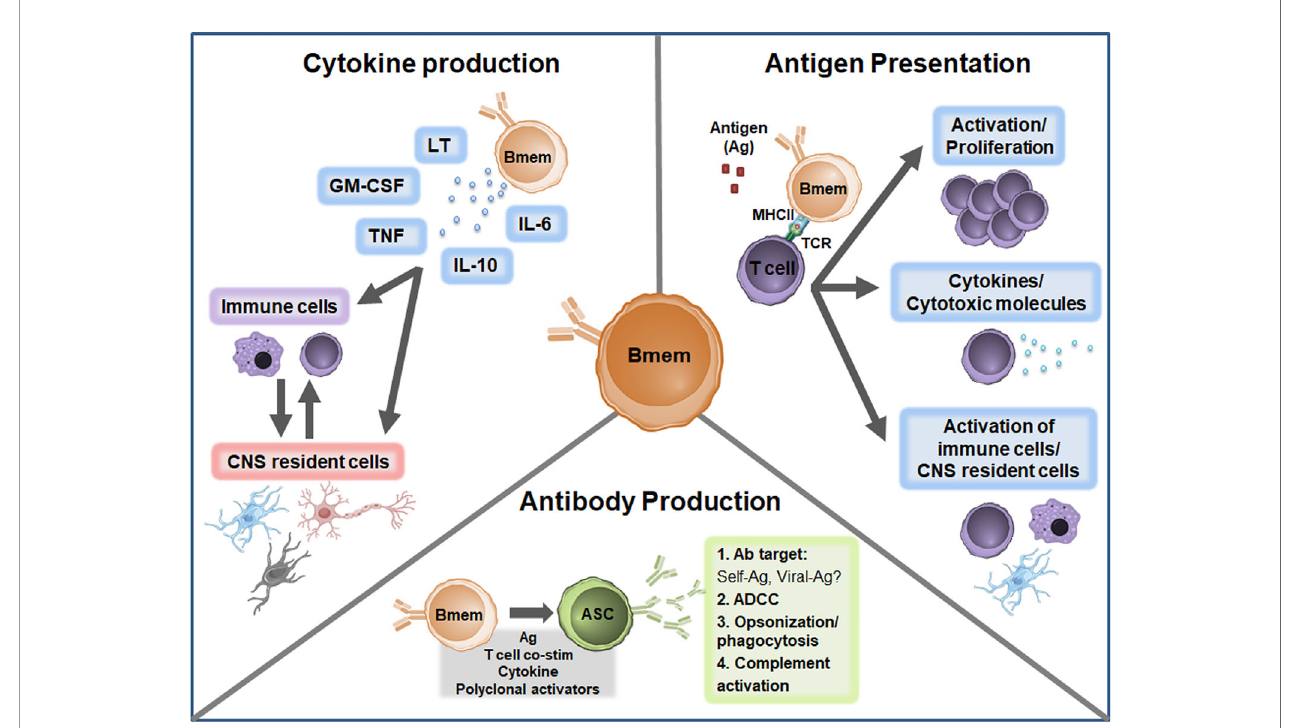
FIGURE 3 | Proposed Bmem functions in MS. Canonical Bmem functions include cytokine production, antigen presentation, and antibody production. Bmem may produce a variety of pro-in fl ammatory and anti-in fl ammatory cytokines in MS, including lymphotoxin (LT), GM-CSF, TNF, IL-10, and IL-6. The production of these cytokines may 1) modulate the in fl ammatory function of immune cells, including monocytes and T cells in the periphery or CNS or 2) may alter the function and survival of CNS resident cells, including neurons, astrocytes, microglia, and oligodendrocytes. Bmem-derived cytokines may also modulate the interactions between CNS-localized immune cells and CNS resident cells. Bmem are potent antigen presenting cells (APCs) and upon uptake and presentation of antigen (Ag) may interact with other immune cells, including T cells, to enhance cell proliferation and effector functions. For example, following T cell-Bmem interaction, activated T cells may engage in cytokine production or cytotoxic molecule secretion. Bmem antigen presentation to T cells may also modify T cell engagement with other immune cells in the periphery or CNS and interaction with CNS resident cells. Bmem can differentiate into ASC following stimulation, including re-exposure to antigen, T cell co-stimulation (co-stim), cytokine stimulation, or T cell-independent polyclonal stimulation. Upon differentiation, Bmem-derived ASC may be involved in sustaining antibody responses in the CNS compartment. Bmem-derived ASC may also contribute to several antibody-dependent functions implicated in MS, including targeting self or viral antigens, antibody-dependent cellular cytotoxicity (ADCC), opsonization/phagocytosis, and complement